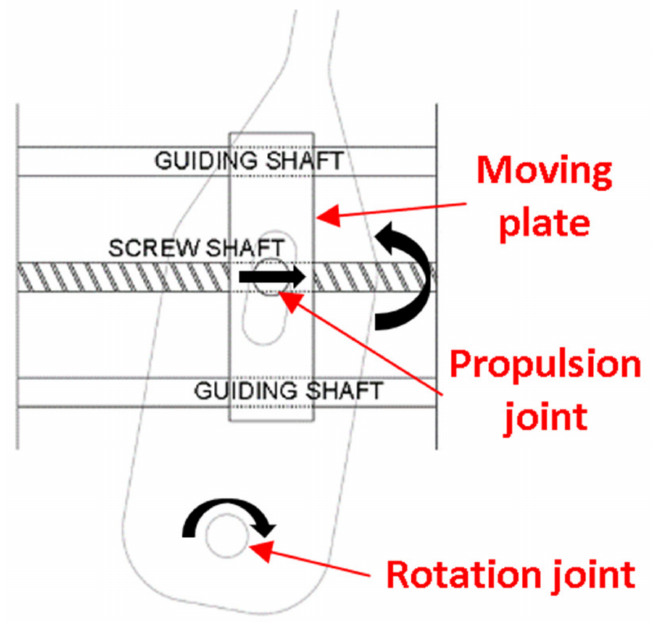
Figure 8. Mechanical parts of the levers motion